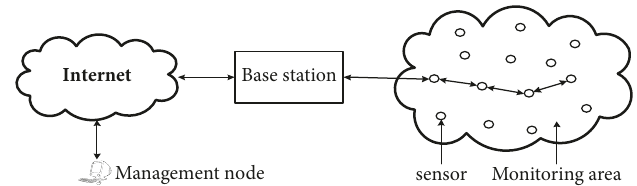
Figure 2: Wireless sensor network architecture